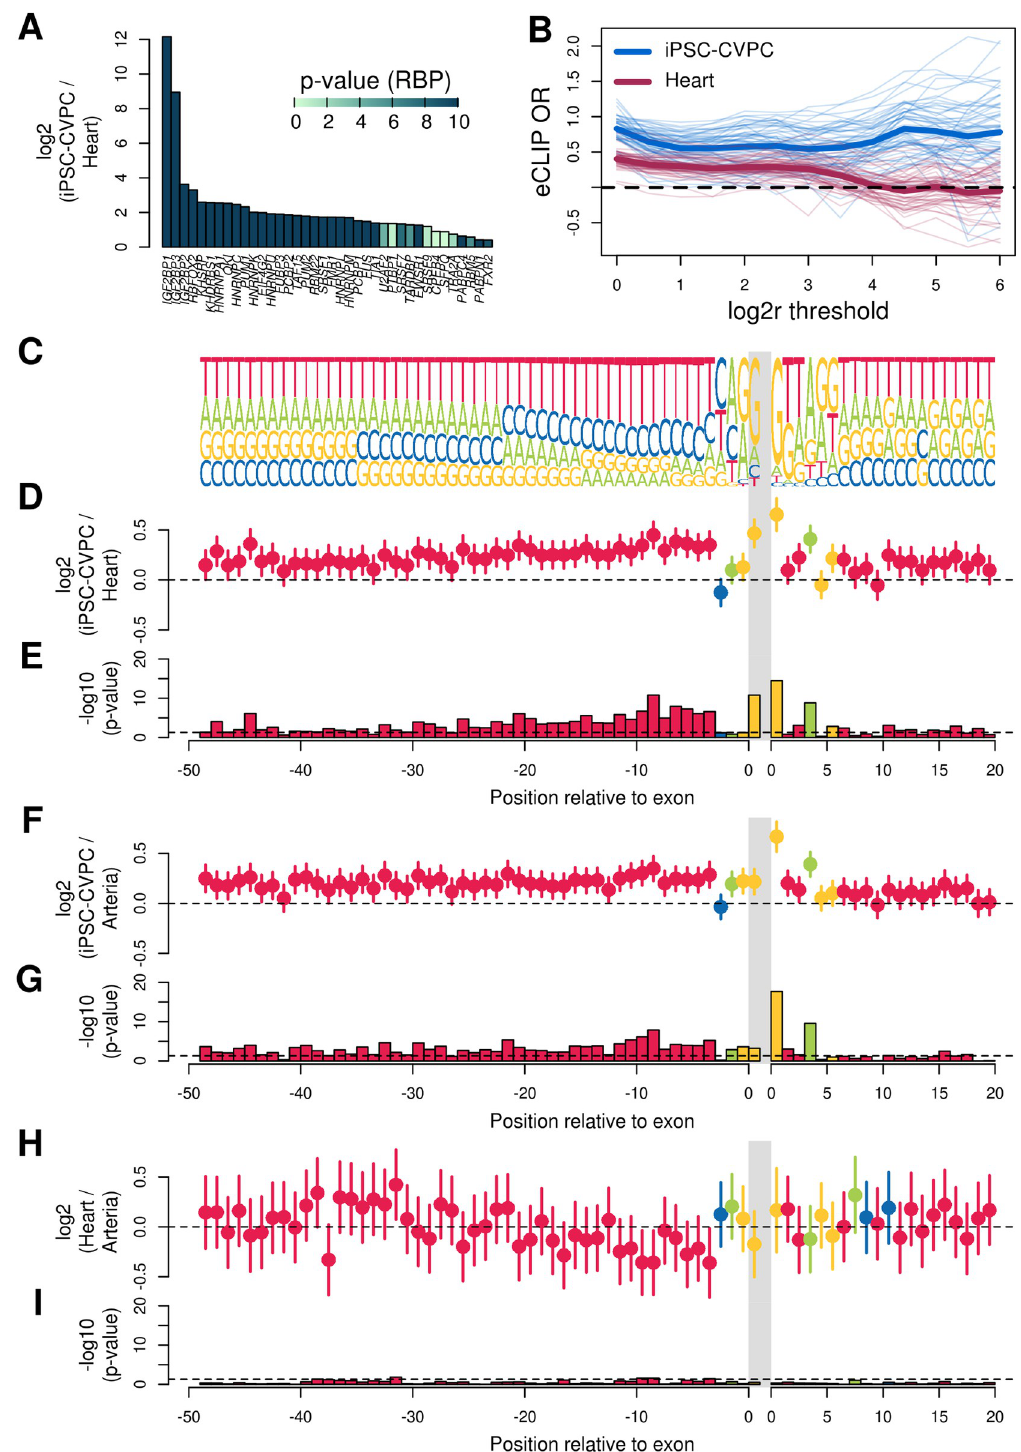
Fig 3. iPSC-CVPC-specific exons are enriched for RBP binding and canonical splice sites. (A) Barplot showing the differential expression of 38 RBPs with experimentally determined (eCLIP) binding sites between iPSC-CVPC and adult heart. Colors represent p-values (S3 Table). Each row represents one RBP. (B) Plot showing the enrichment of genomic loci encoding iPSC-CVPC-specific isoforms and adult-heart specific isoforms for overlapping experimentally determined (eCLIP) RBP binding sites. Each line corresponds to an eCLIP experiment. The X axis corresponds to log 2 ratio thresholds (mean